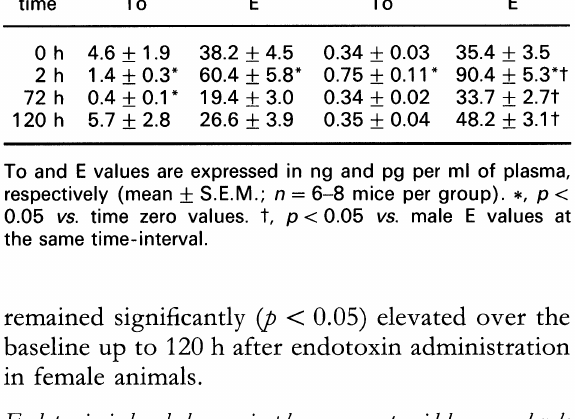
Table 1. Plasma testosterone (To) and estradiol (E) levels before and several times after the administration (i.p.)